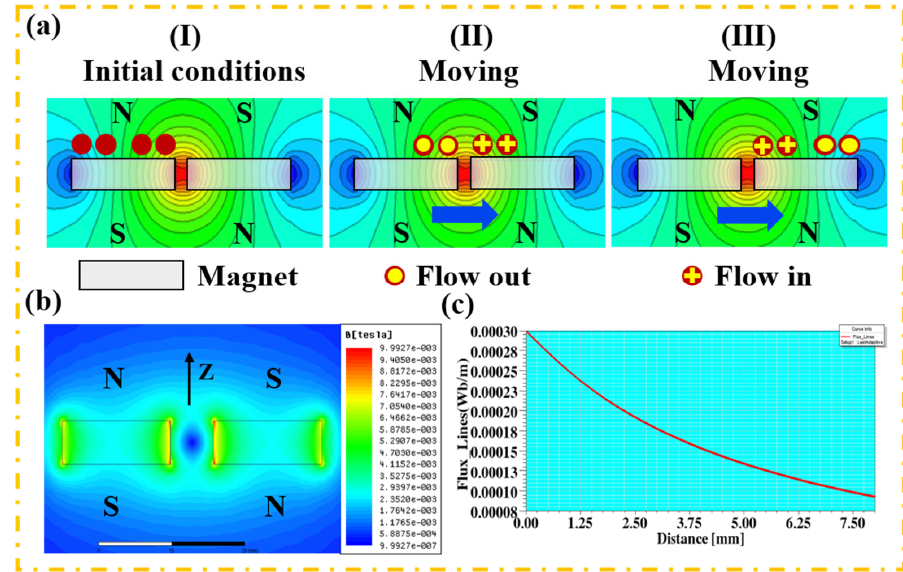
Figure 3. The working principle and simulation of EMG: ( a ) working principle of EMG; ( b ) simulation of magnetic field intensity distribution between two adjacent magnets; ( c ) simulation of the relationship between the flux lines and the magnet at different longitudinal distances (z ‐ axis).